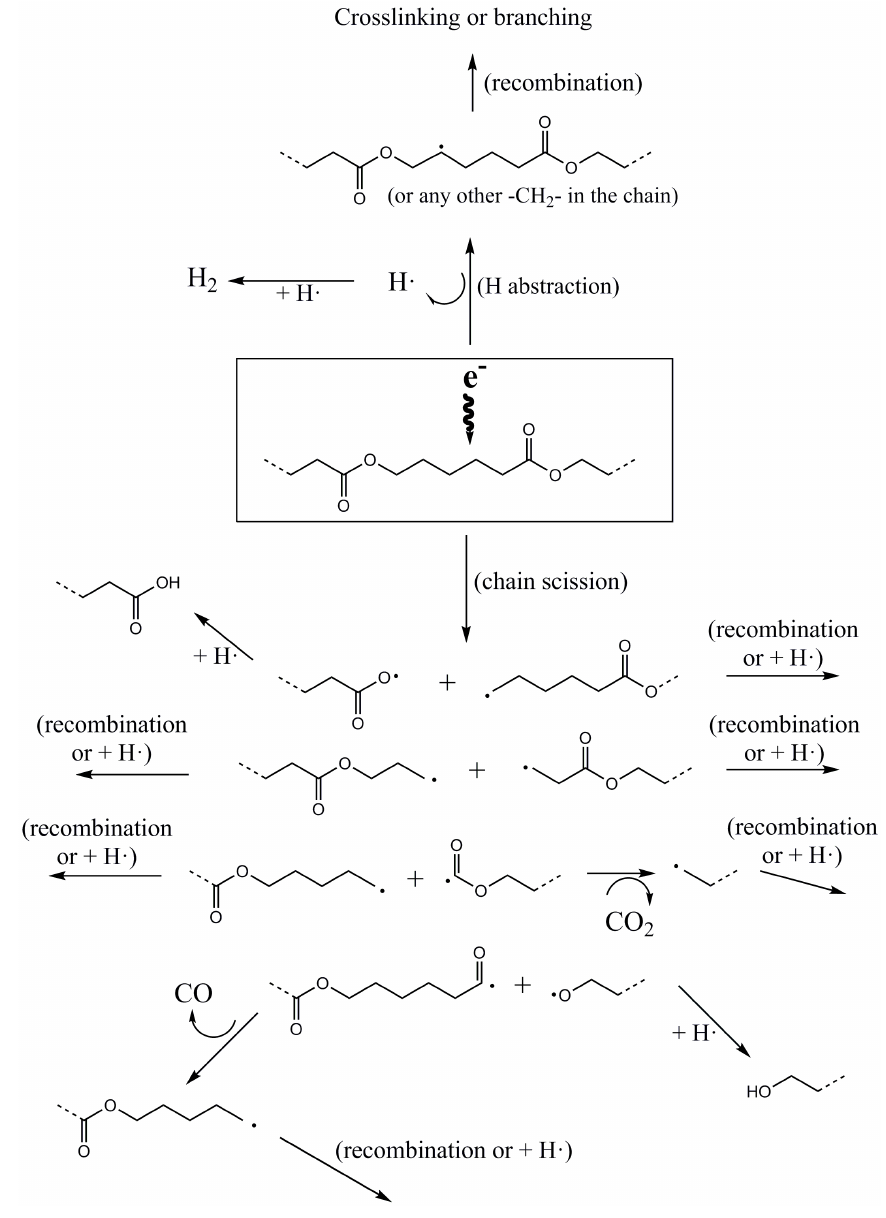
Figure 4. Proposed mechanism of degradation of PCL by electron-beam irradiation.